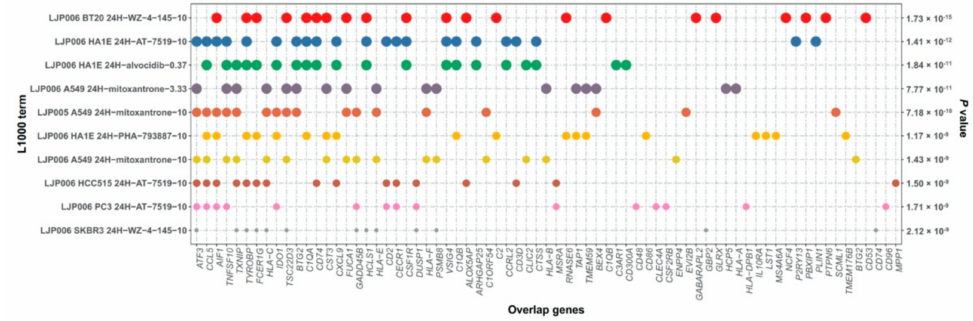
Figure 6. Bubble plot showing the distribution of the genes for each LINCS L1000 Chem Pert category. The color of the bubbles represents the L1000 term, and the size of the bubbles indicates the p -value of the